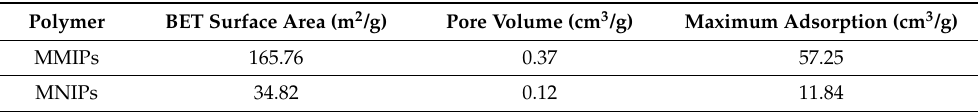
Table 1. Fe 3 O 4 @MMIPs and Fe 3 O 4 @MNIPs surface area and porosity based on the application of the BET method.